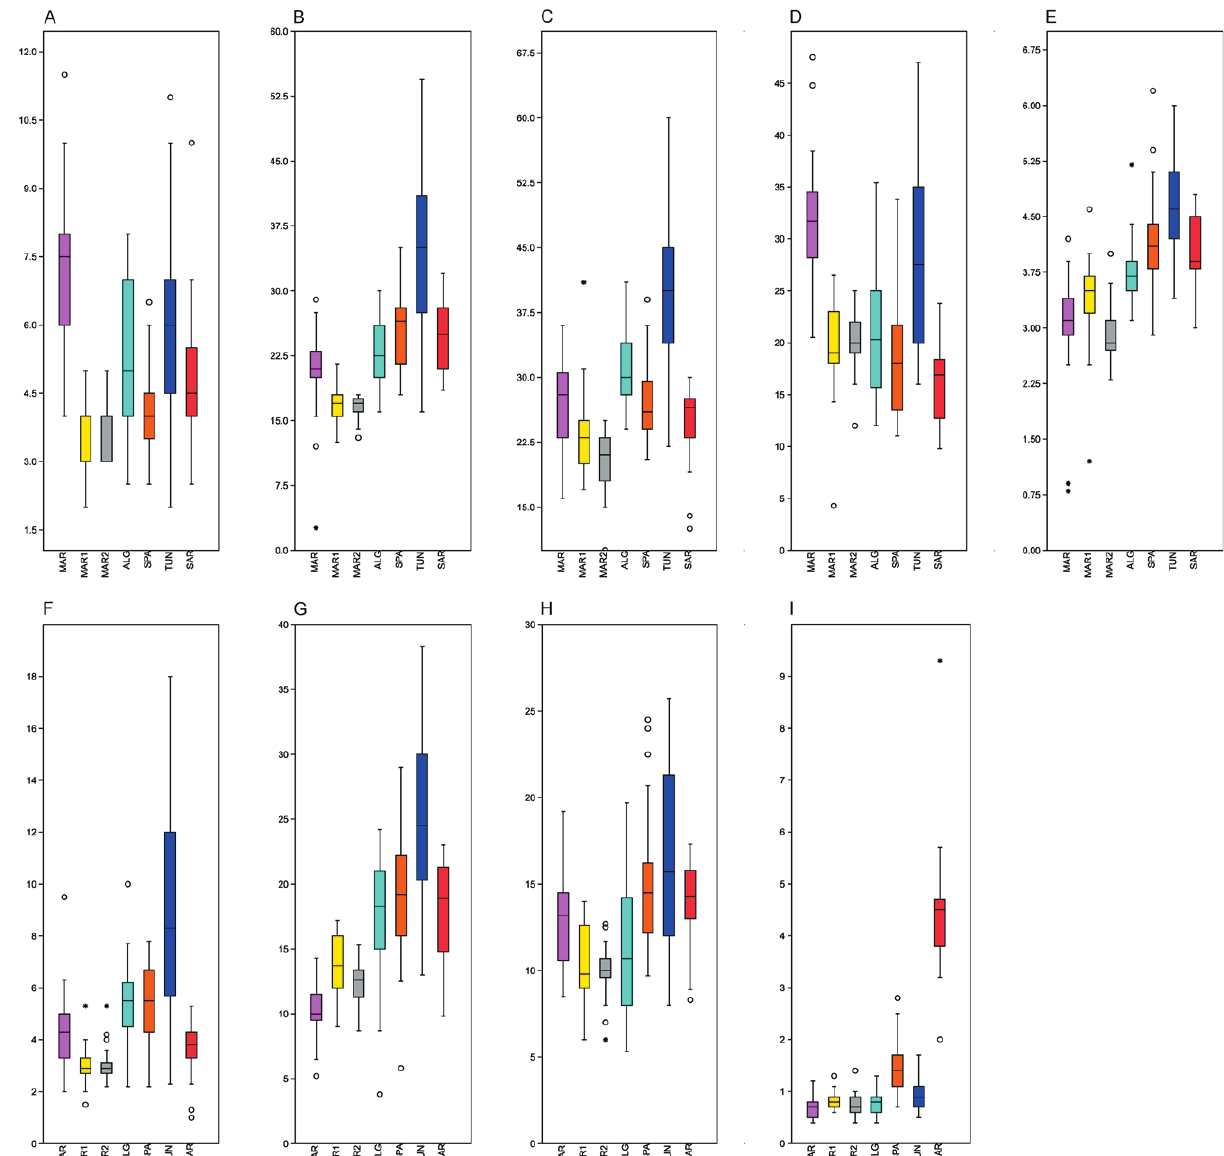
Figure 4. Box-plots of the 9 continuous morphological characters considered (A: height of the Stem (cm); B: Height of the Plant (cm); C: Crown diameter (cm); D: Stem diameter (mm); E: Petiole length (cm); F: Petiole width (cm); G: Leaf length (cm); H: Leaf width (cm); I: Leaf thickness (mm). For each sample, the 25–75% quartiles are drawn using a box. The median is shown with a horizontal line inside the box. The whiskers are drawn from the top of the box up to the largest data point less than 1.5 times the box height from the box, and simi- larly below the box. Values outside the inner fences are shown as circles, values further than 3 times the box height from the box are shown as stars. MAR (fuchsia): Terketen, Morocco; MAR1 (yellow): Beni Mellal, Morocco; MAR2 (grey): Touama, Morocco; ALG (light blue): Sidi Belattar, Algeria; SPA (orange): Valencia, Spain; TUN (blue): Cap Serrat, Tunisia; SAR (red): Porto Tangone, Sardinia,